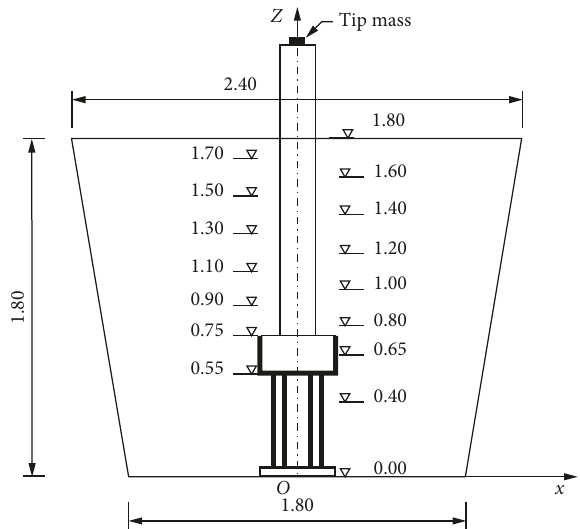
Figure 4: Water levels considered during the tests; all dimensions are in